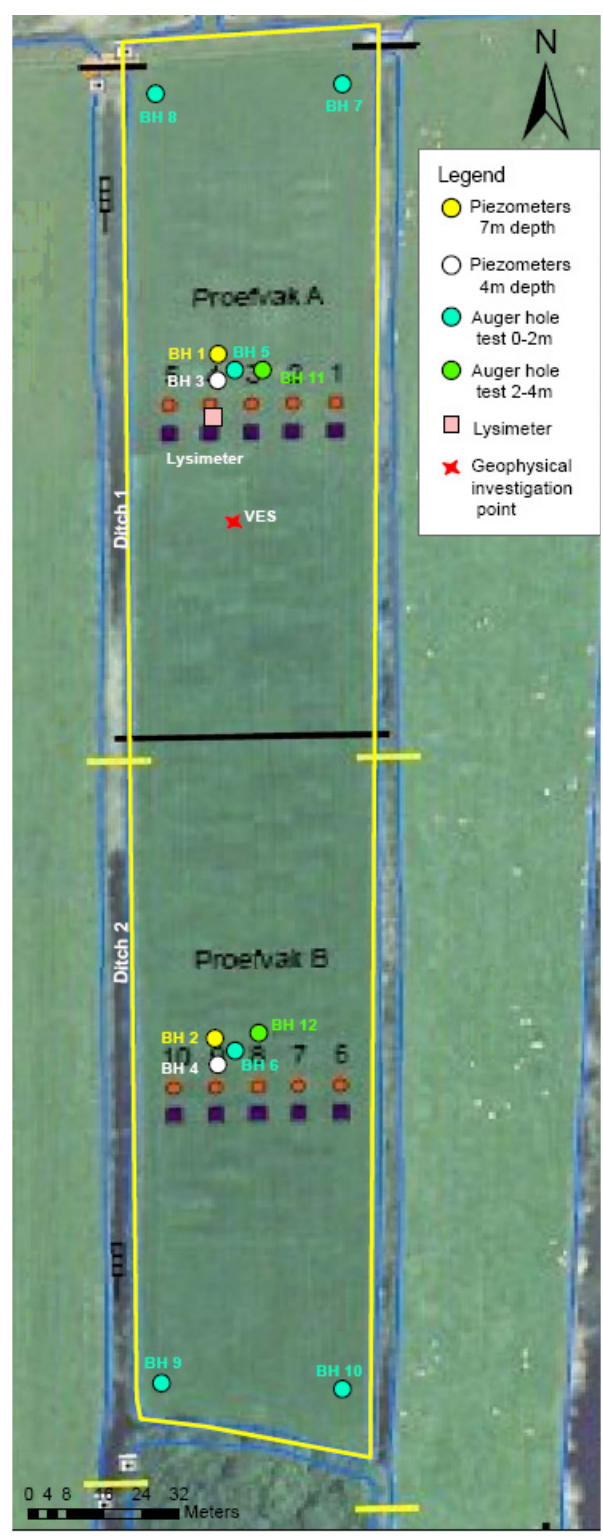
Fig. 2 Location of the installed equipment and experiments carried out during fieldwork Fig. 2. Location of the installed equipment and experiments carried out during